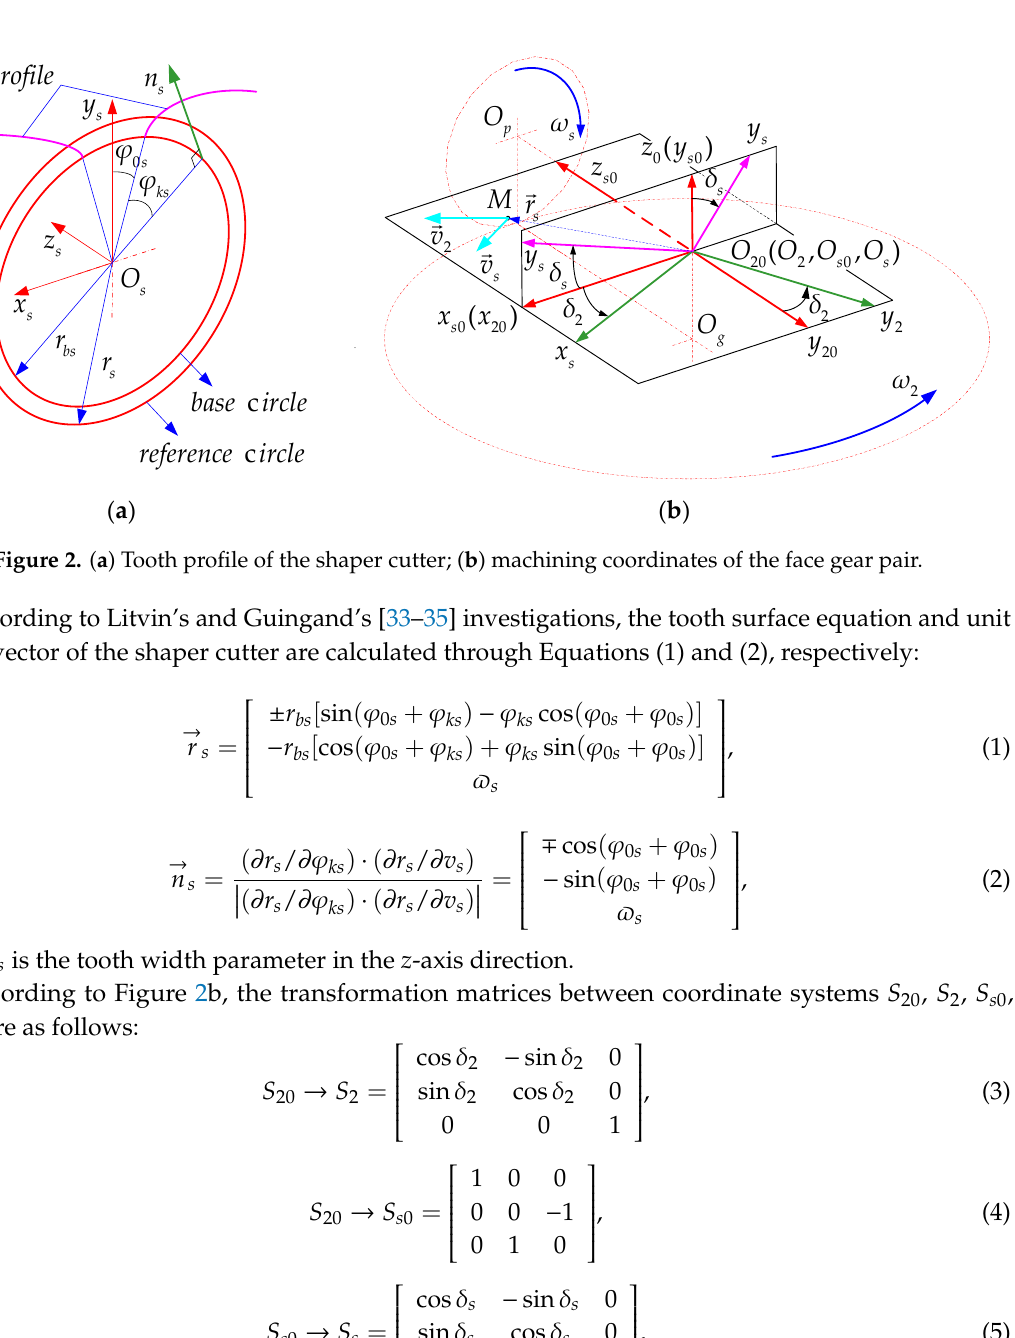
Figure 1. Flowchart of establishing face gear tooth surface equations.